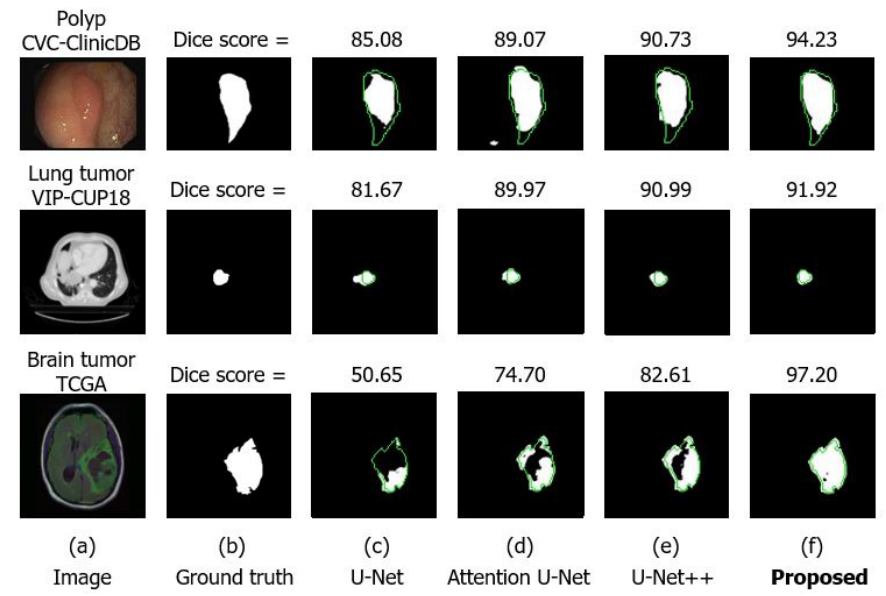
Figure 6. Representative results from three datasets by using different U-Net architectures.